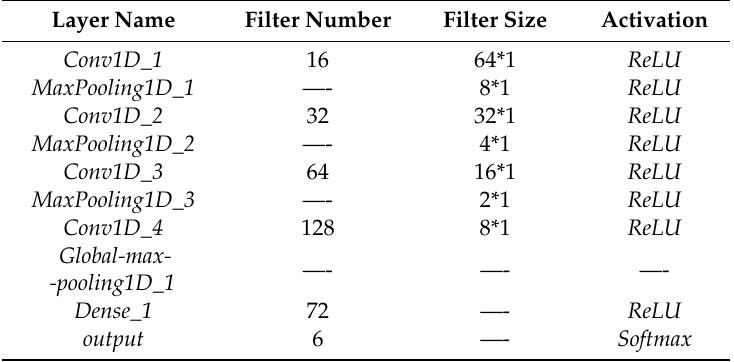
Table 2. Model structure of the employed 1D